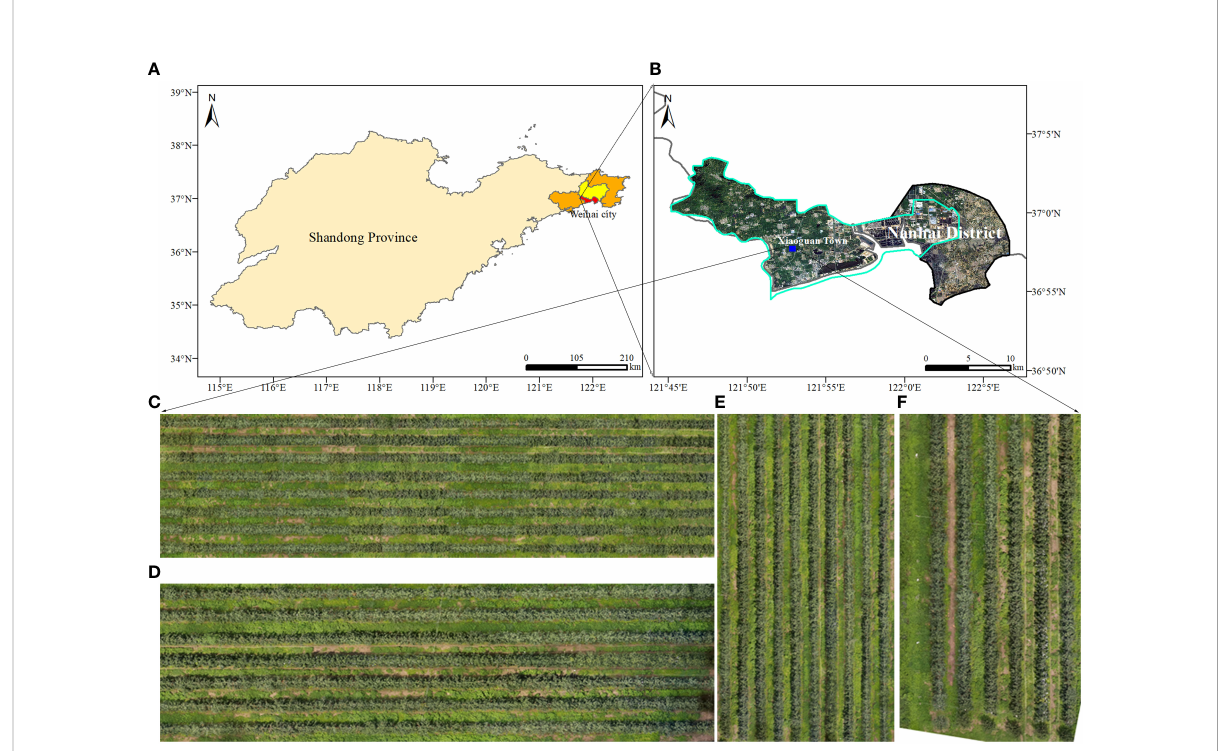
FIGURE 1 Test location of image capture. (A, B) The location of the experimental orchard. (C-E) Digital orthophoto maps for training and (F) for testing in canopy